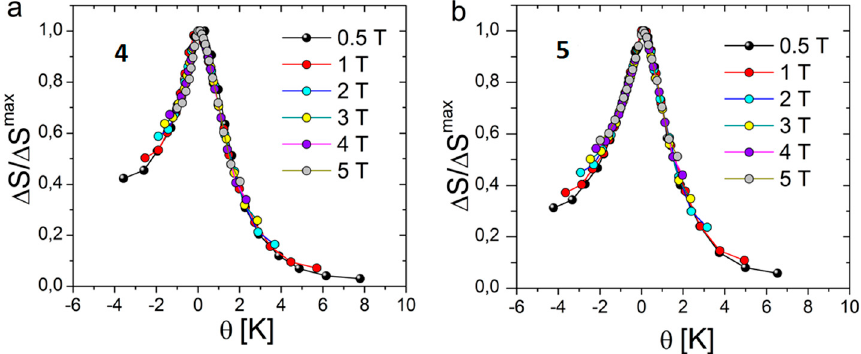
Figure 21. Universal curves of ferrimagnetic {[Mn II (H 2 O) 2 ] 2 [Nb IV (CN) 8 ] · 4H 2 O} n ( 4 ) ( a ) and ferromagnetic {[Fe II (H 2 O) 2 ] 2 [Nb IV (CN) 8 ] · 4H 2 O} n ( 6 ) ( b )